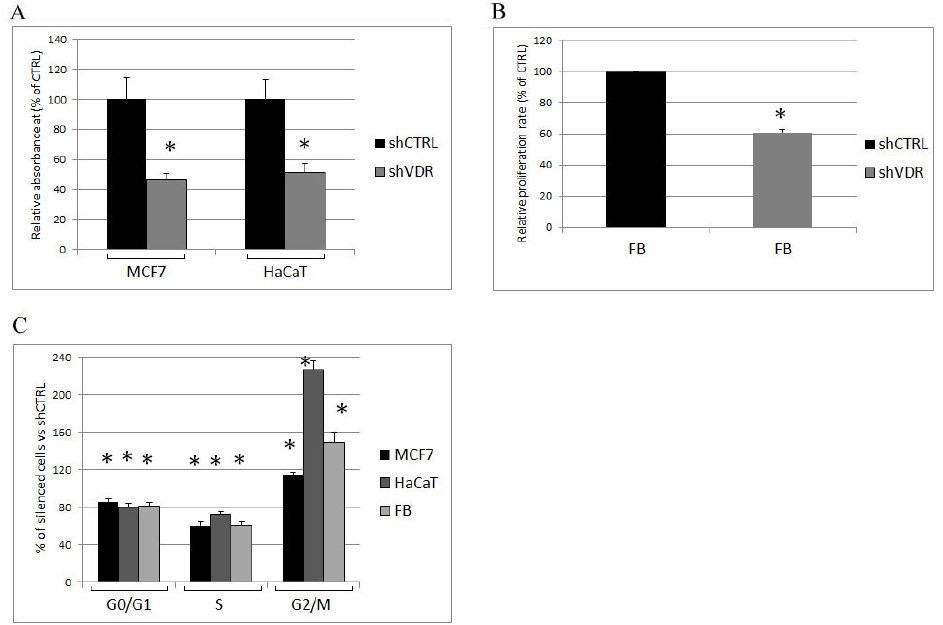
Figure 2. Analysis of cell proliferation in silenced cells. One week after infection, the control (shCTRL) and VDR knockdown cells (shVDR) were seeded and assayed for ( A ) proliferation rate, measured by crystal violet staining or ( B ) BrdU incorporation; ( C ) The cell cycle of MCF7, HaCaT, and fibroblasts (Fb) was evaluated by cytofluorimetry, and the distribution of the silenced cells throughout the cell cycle was expressed as percentage of the shCTRL cells in the same phase. The data are expressed as the means ± SD of three independent experiments; * p < 0.05 compared to the control.